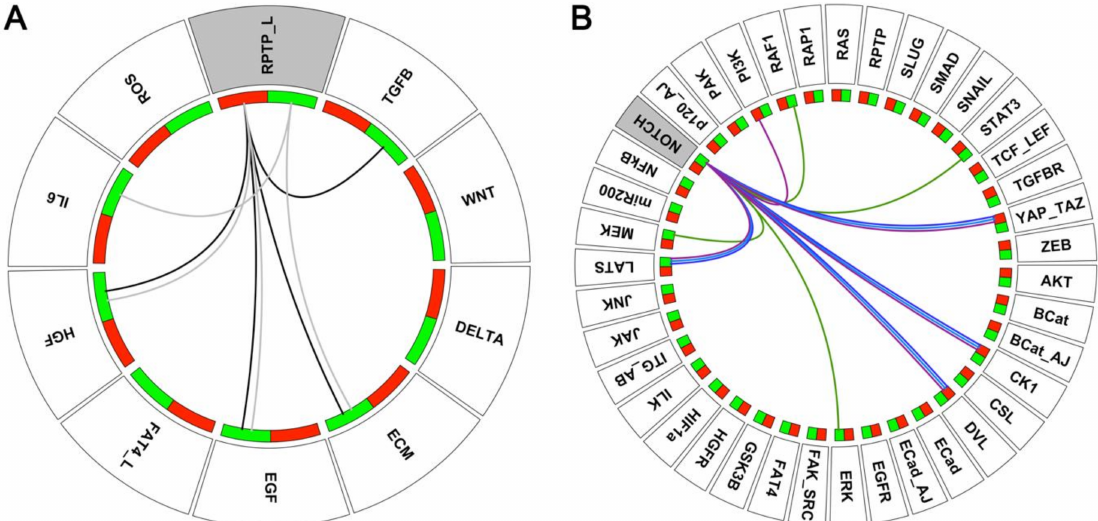
Figure 5. Diagrams summarising cooperative interactions predicted by our EMT model ( A ) Cooperative interactions between RPTP_L and other inputs from the TME in the absence of a NOTCH Gof mutation (black edges) or in the presence of a NOTCH GoF mutation (grey edges) using reachability analysis starting from the E1 phenotype (see Table S1). Coloured rectangles associated with each input provide the value of the input, green for the value 1 (active) and red for 0 (non-active). All remaining inputs are set to 0. ( B ) Cooperative interactions between a NOTCH GoF mutation (NOTCH E1) and other internal variables of the model, by systematic analysis of the phenotype compatible with the different conditions. Coloured edges connecting two variables indicate the phenotypes lost in double mutants but observed in both single mutants: green edges for the epithelial E1 phenotype, light blue edges for the hybrid H1 phenotype; darker blue edges for the hybrid H2 phenotype and magenta edges for the hybrid H3 phenotype. Coloured rectangles associated with each variable provide the type of mutations: green for a GoF mutation, red for a LoF mutation.